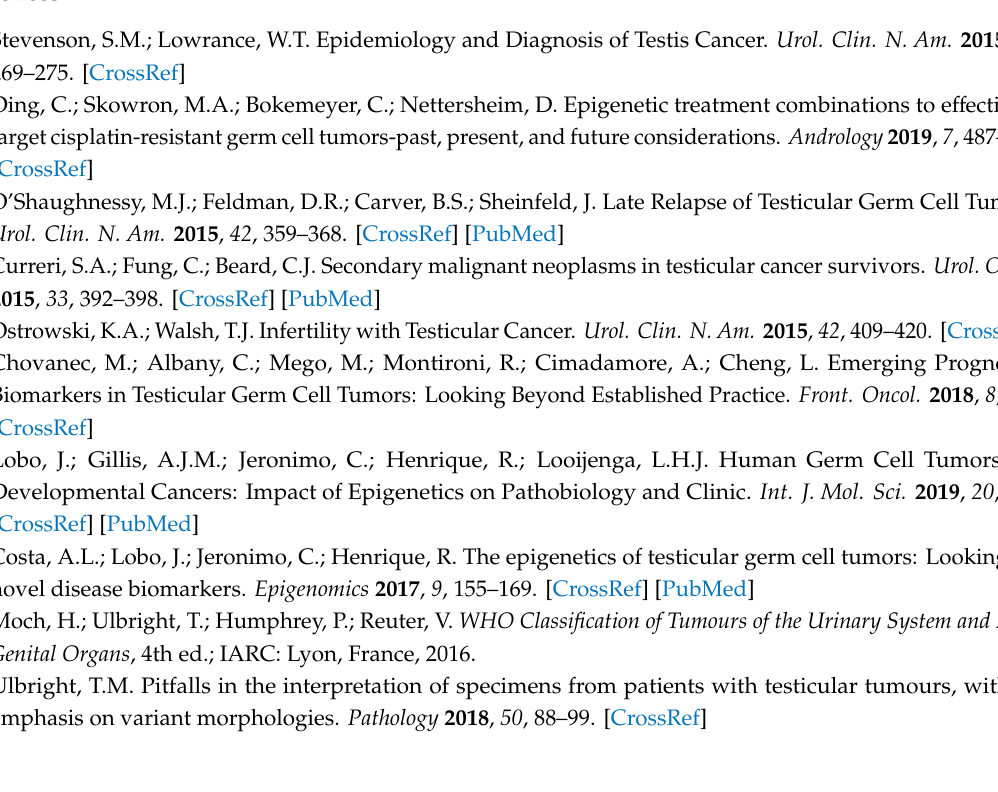
Figure S1: Immunoexpression of CTLA-4 in immune cells of testicular germ cell tumors and association with prognostic features, Figure S2: Relapse-free survival according to CTLA-4 immunoexpression in immune cells of testicular germ cell tumors, Figure S3: Characterization of the immune infiltrate populating pure seminomas, Figure S4: Illustrative examples of characteristics of the immune infiltrate in pure seminomas, Figure S5: Absent and weak immunoexpression of CTLA-4 in tumor cells, Figure S6: Relapse-free survival according to CTLA-4 immunoexpression intensity in tumor cells of testicular germ cell tumors, Figure S7: Relapse-free survival according to PD-L1 immunoexpression in tumor cells of testicular germ cell tumors, Figure S8: Immunoexpression of PD-L1 and CTLA-4 among primary and metastatic testicular germ cell tumor samples, Figure S9: Immunoexpression of mismatch repair proteins in metastatic testicular germ cell tumor samples. Combined score for MLH1 (A), PMS2 (B), MSH2 (C) and MSH6 (D) among residual mature teratoma and non-teratoma viable disease, Figure S10: mRNA expression of CTLA-4 in the TCGA database for Testicular Germ Cell Tumors. Table S1: Mixed Testicular Germ Cell Tumors and proportions of each component, Table S2: Immunohistochemistry methodology details. Table S3: Raw data related to immunoscoring of primary tumor samples, Table S4: Raw data related to immunoscoring of metastatic